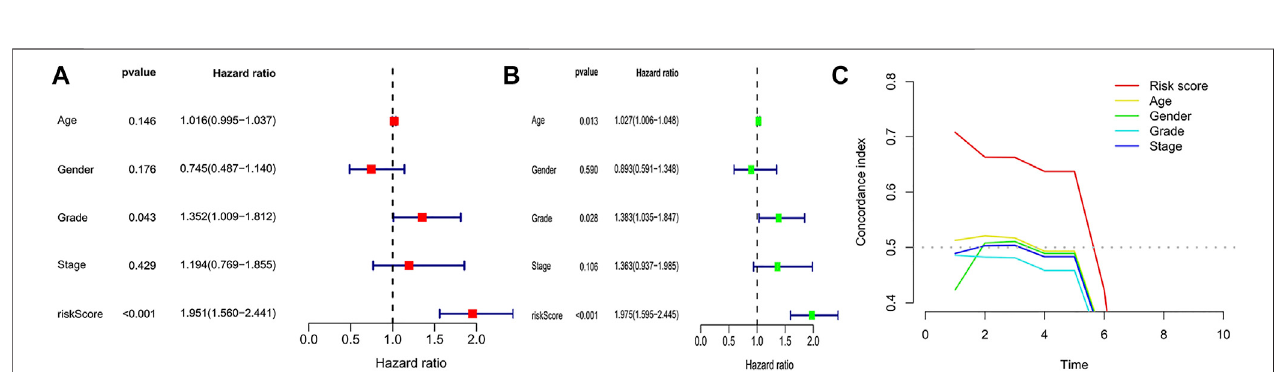
FIGURE 2 | (A) Cox univariate analysis. (B) Cox multivariate analysis. (C) c-index analysis